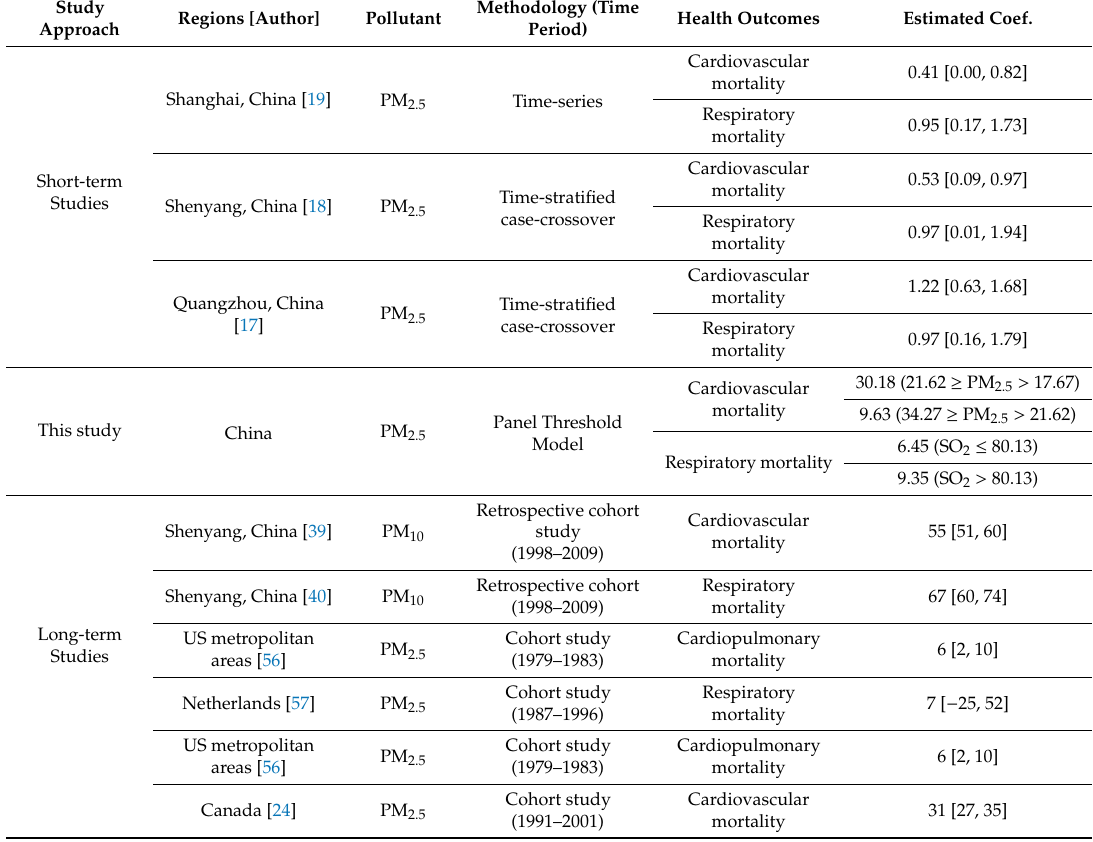
Table 8. The percentage change in cause-specific mortality associated with a 10 µ g/m 3 increase in PM 2.5